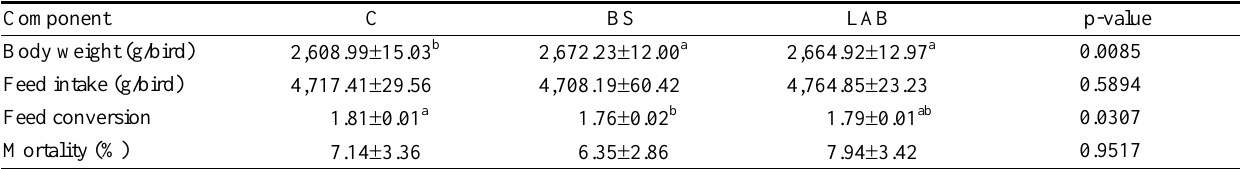
Table 2. Effect of probiotic supplementations on total feed intake, body weight, feed conversion ratio and mortality in broilers at 42 d